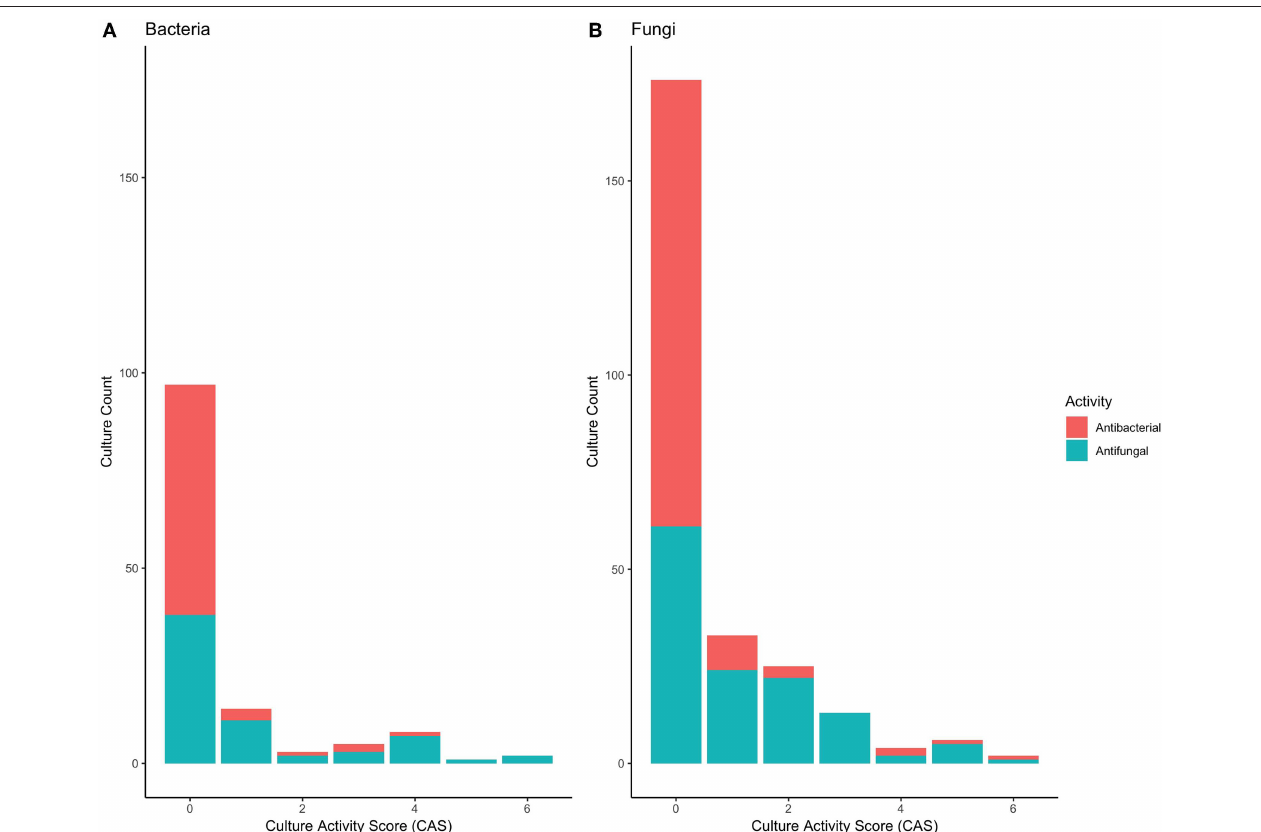
FIGURE 5 | Antipathogen activity scores for (A) 66 bacterial, and (B) 131 fungal isolates, based on the measured minimum inhibitory concentrations (MIC sensu , Rodrigues et al., 2019). Both antifungal and antibacterial activity for each isolate was determined. A value of 0 indicates no inhibition and thus no antipathogen activity, whilst a value of 6 indicates high inhibition and thus antipathogen